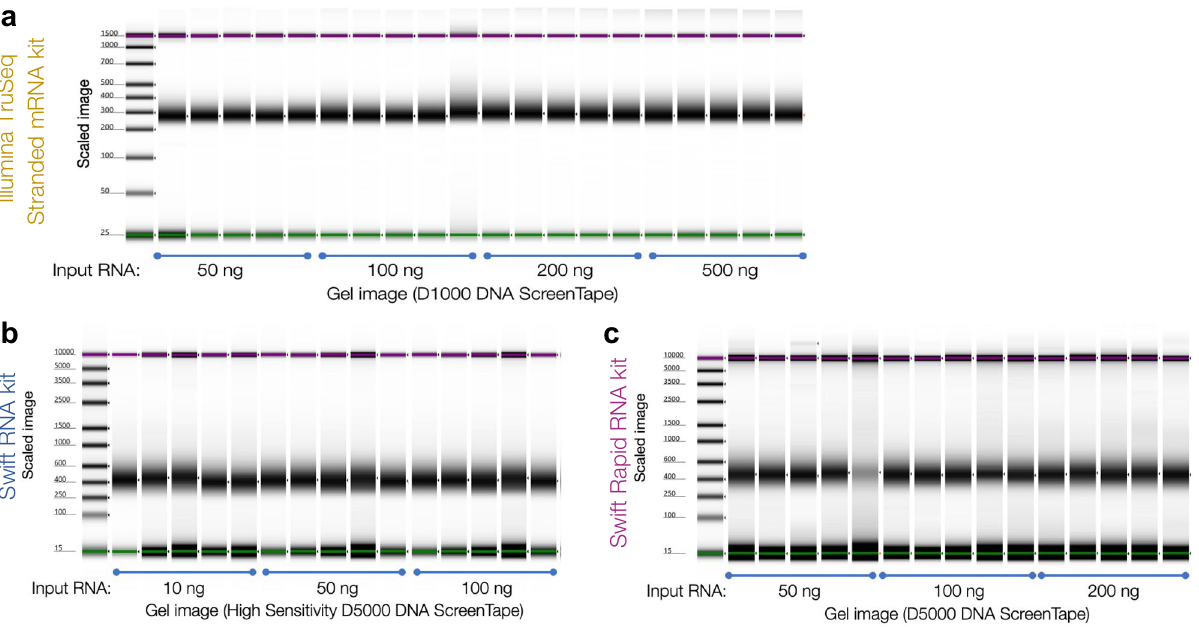
Figure 2. Agilent Tapestation 4200 electropherograms of all libraries prepared using the ( a ) Illumina TruSeq stranded mRNA kit, ( b ) Swift RNA kit, and ( c ) Swift Rapid RNA kit. All methods produced high-quality